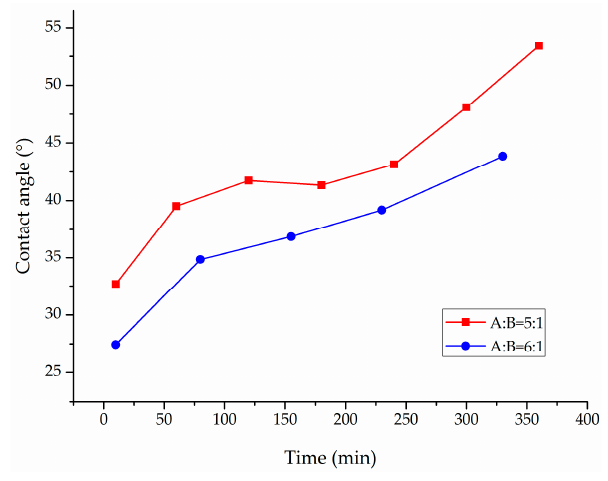
Figure 7. The change curve of contact angle of the slurry.